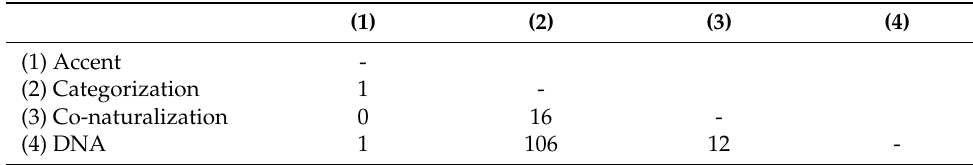
Table 4. Co-occurrence of focal raciolinguistic ideologies.